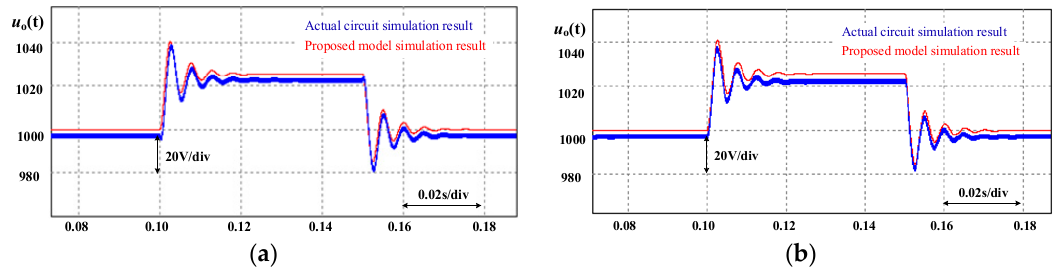
Figure 9. VM number is 5, C na = C nb = 2 μ F, and ( a ) duty cycle changes; ( b ) input voltage changes.